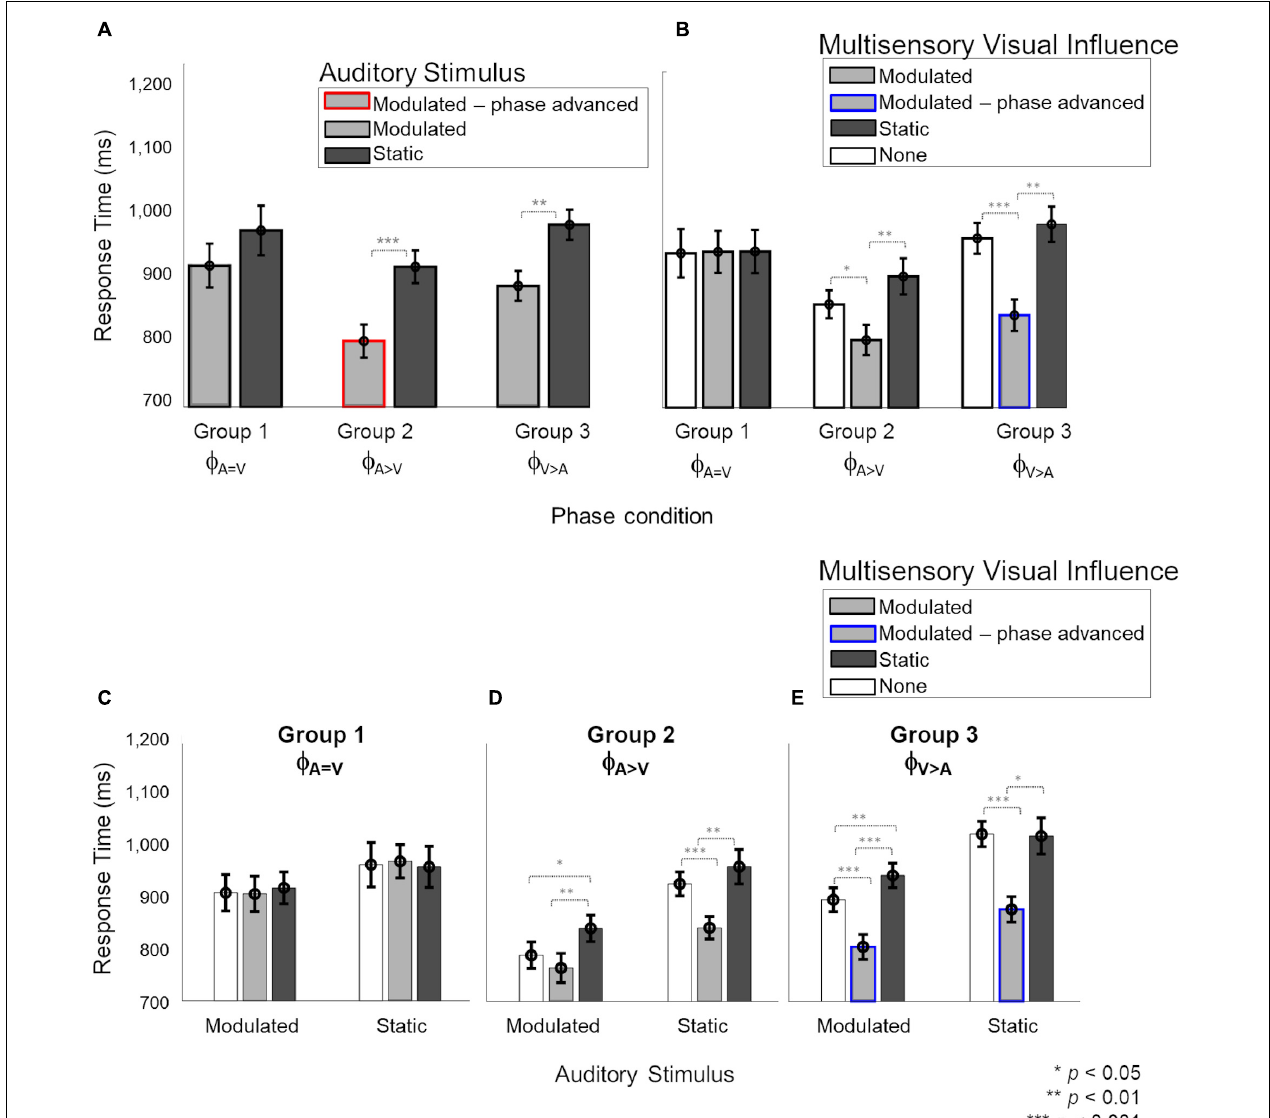
FIGURE 4 | Response times during the auditory task with visual influences. In panels (B–E) , light and dark gray bars represent the presence of barely-detectable modulated and static visual influences, respectively, while white bars show the unisensory condition. Red and blue lines indicate phase-advanced auditory and visual conditions, respectively. Error bars represent ± 1 SEM. Panels (A,B) show the main effects of “Auditory stimulus” (2 levels: modulated – static) and “Visual influence” (3 levels: none – modulated – static), respectively. Panels (C–E) the interaction of “Auditory stimulus” and “Visual influence” plotted for separately for phase conditions φ A = V , φ A > V and φ V > A , respectively. While no effect of the visual influence on the auditory stimulus was observed in phase condition φ A = V (C) , responses to sounds were significantly faster when a modulated compared to static visual influence was present in phase conditions φ A > V and φ V > A (D,E) . (C) For phase condition φ A = V , when the auditory stimulus and visual influence were in-phase (no phase shift for modulated stimuli), no significant interaction between the auditory stimulus and visual influence was observed. (D) For phase condition φ A > V (modulation phase of the auditory stimulus was leading with respect to that of the visual influence), we observed an overall distraction effect of the static visual influence and no advantageous effect of the visual influence for modulated auditory stimuli. Response times for the static auditory stimuli became faster due to the modulated visual influence. (E) For phase condition φ V > A (the modulation phase of the visual influence was leading with respect to that of the auditory stimulus), an advantage of the modulated visual influence, as well as a disadvantage in case of a static visual influence, were observed compared to unisensory sounds.